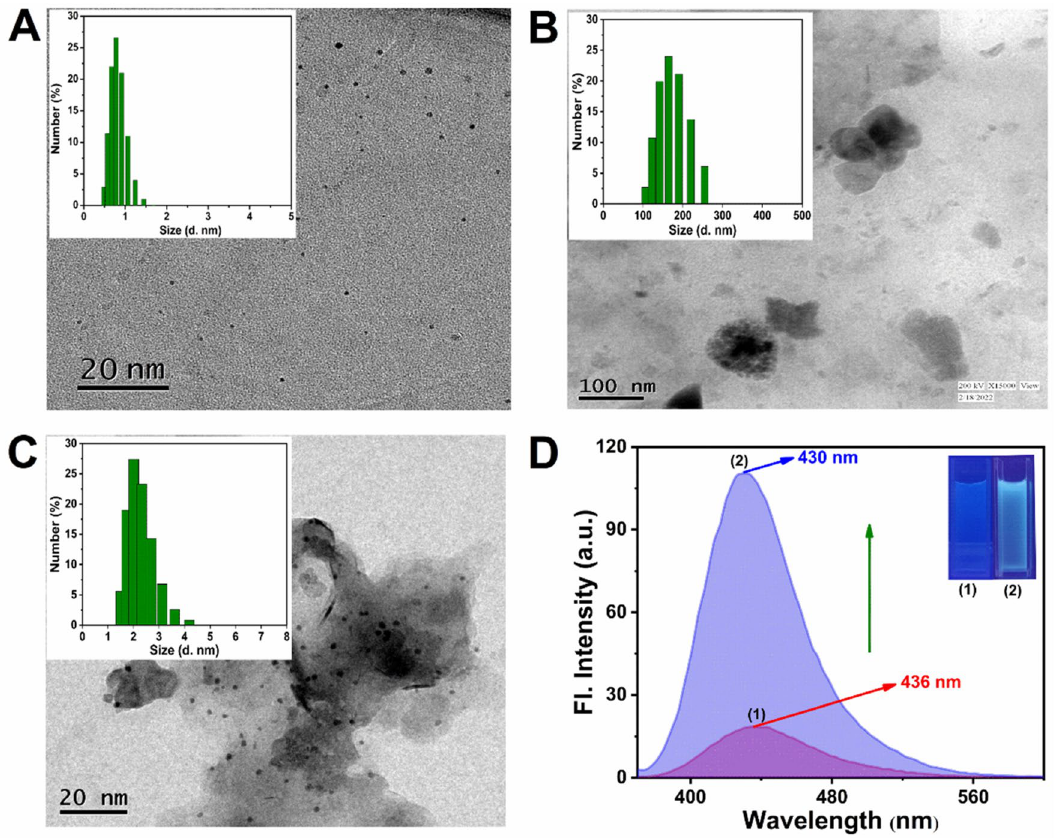
Figure 2. TEM images of ( A ) N-CQDs ( B ) Aggregated N-CQDs by Co 2+ ( C ) Disaggregated N-CQDs by DCA. Inset: the corresponding hydrodynamic diameter measured by DLS ( D ) Fluorescence emission spectra of N-CQDs/Co complex in the (1) absence and (2) presence of DCA. Inset: corresponding fluorescence images under UV light (365